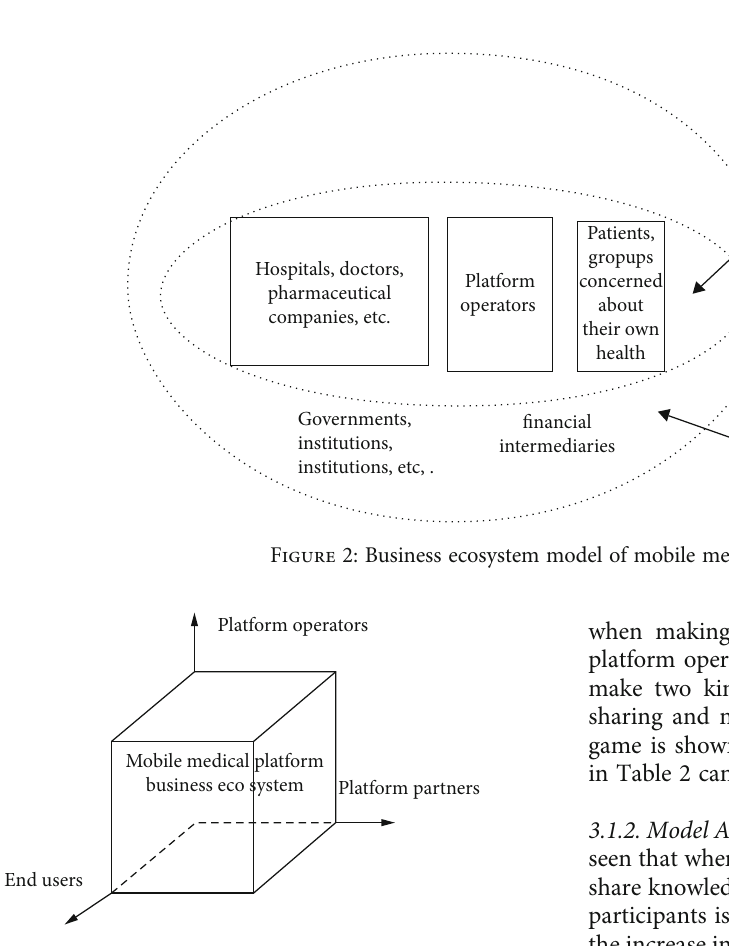
Figure 1: Platform business ecosystem model.